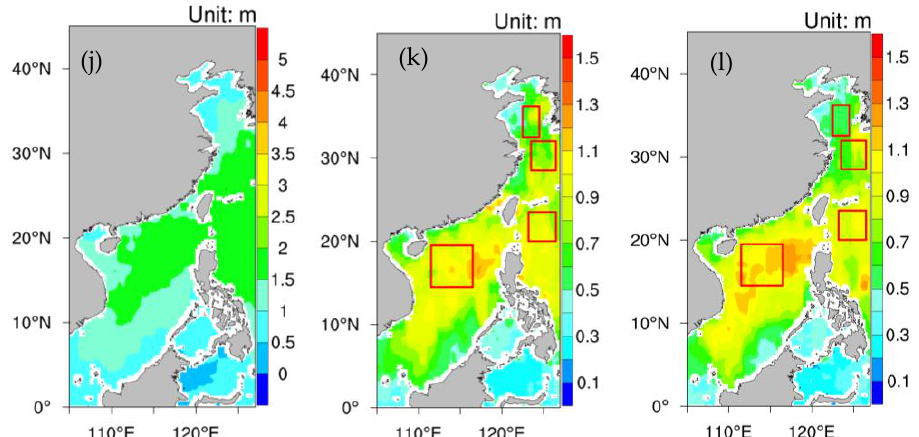
Figure 7. Seasonal mean SWH for CFOSAT and HY − 2B from December 2019 to November 2021. The seasonal mean in DJF ( a ), MAM ( b ), JJA ( c ), and SON ( d ), and the annual mean ( i ) and standard deviation ( k ), respectively. ( e – h , j , l ) As in ( a – d , i , k ) but for HY − 2B. The red boxes in ( k ) and ( l ), from north to south, indicate 4 sea areas of concern in Huanghai, Donghai, East Taiwan, and the central South China Sea, respectively. Table 1. Seasonal field mean SWH and correct